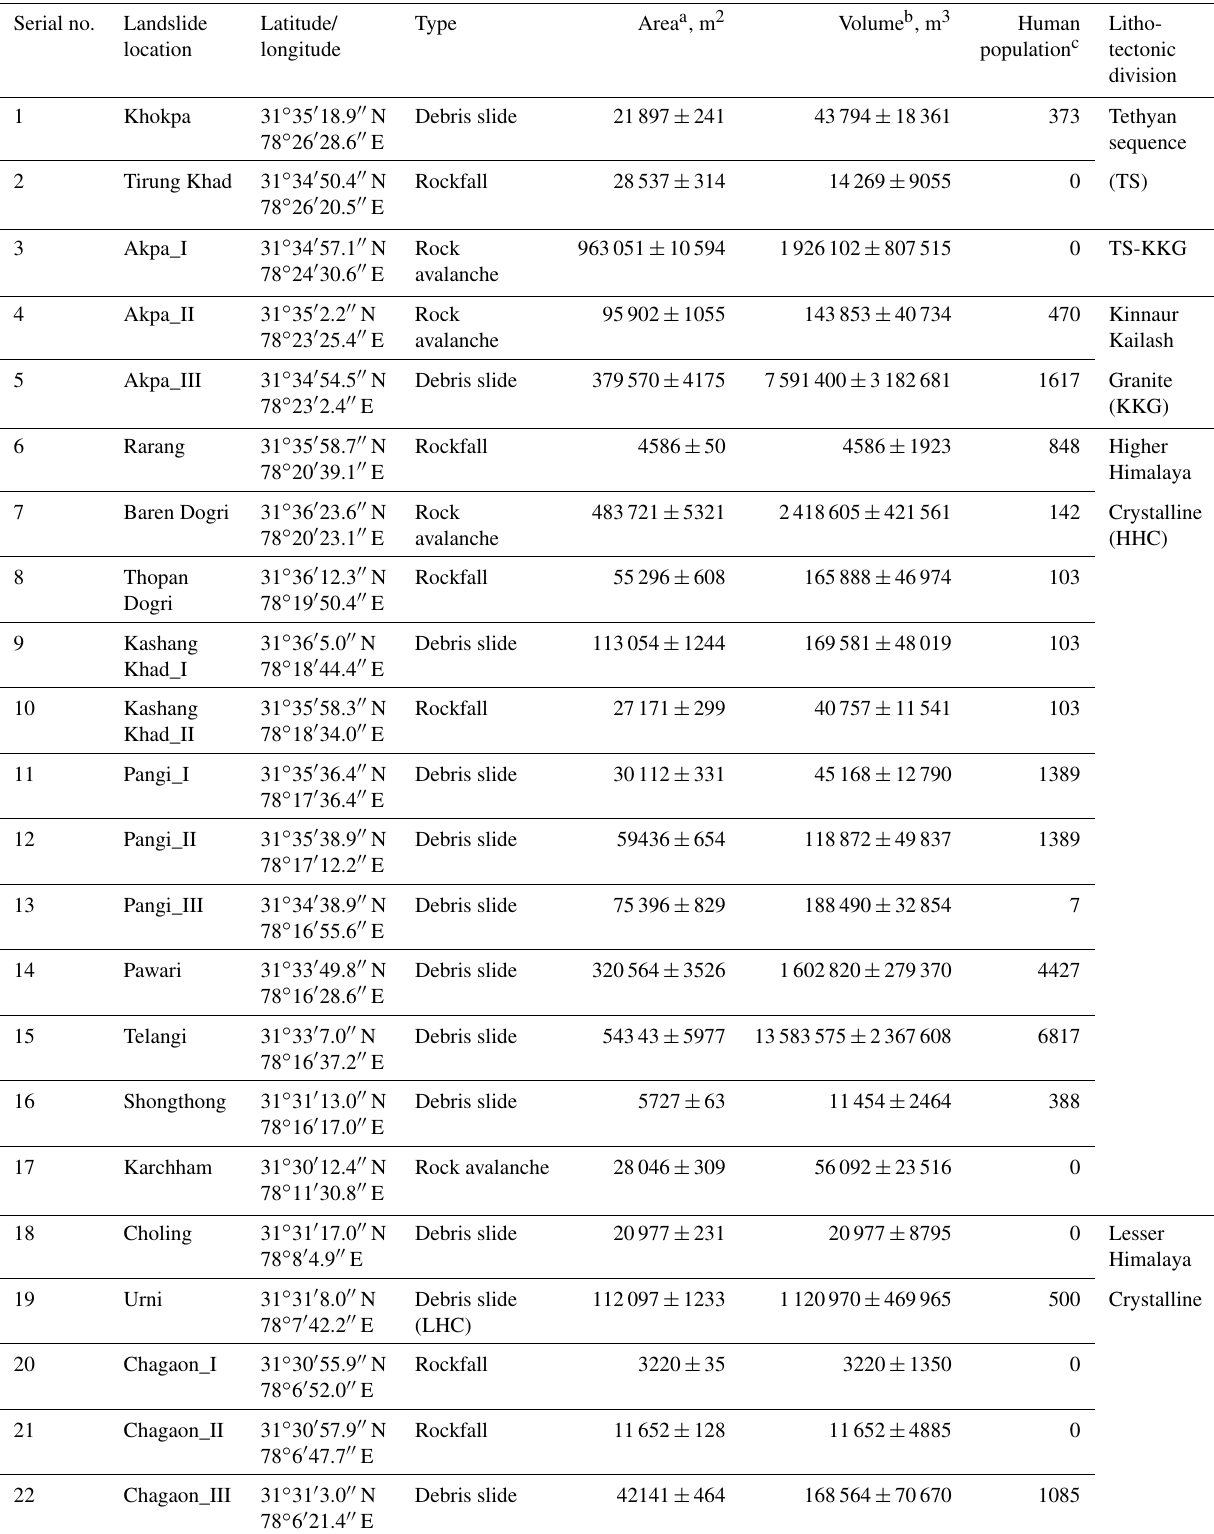
Table 1. Details of the landslides used in the study. Serial